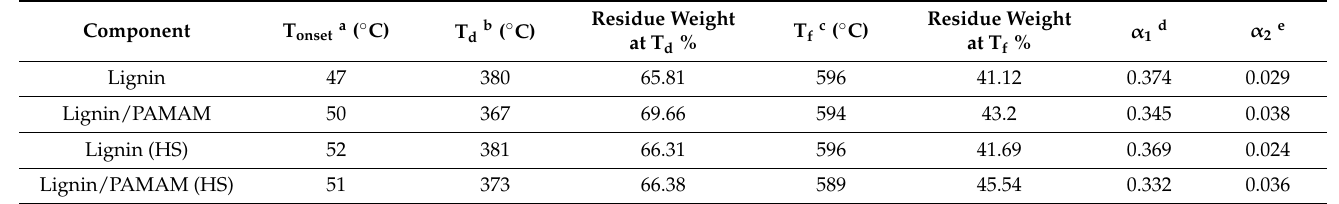
Table 4. The characteristic points of TG and DTG curve at two main peaks for different mat groups.